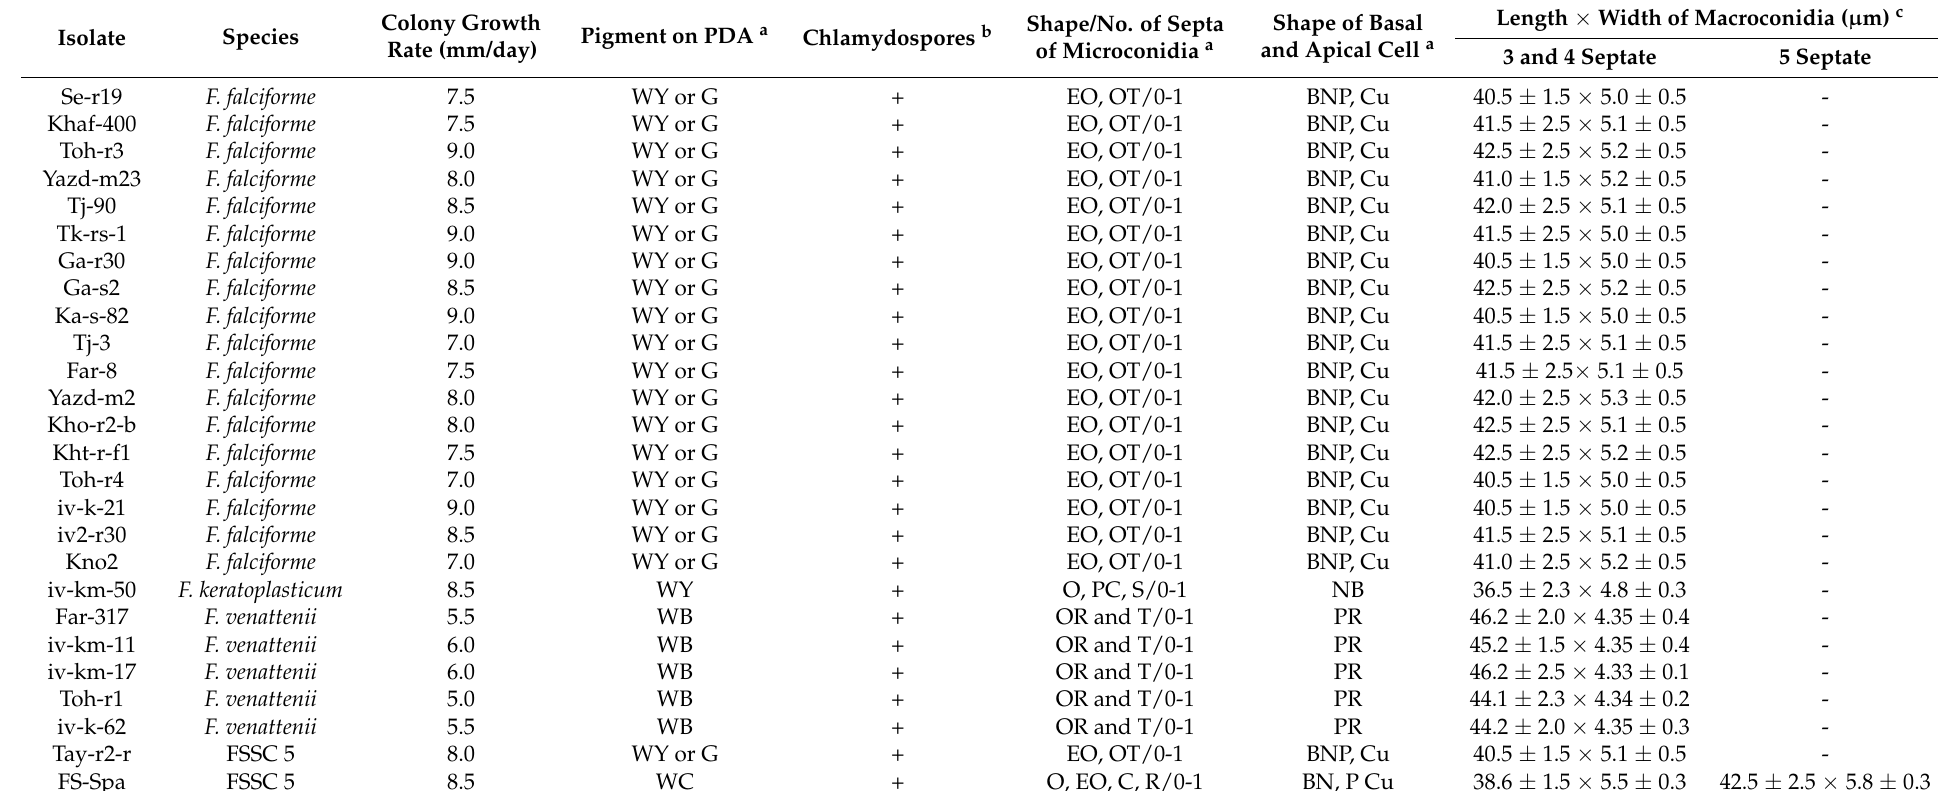
Table 2. Morphological characteristics of FSSC isolates obtained from melon plants in